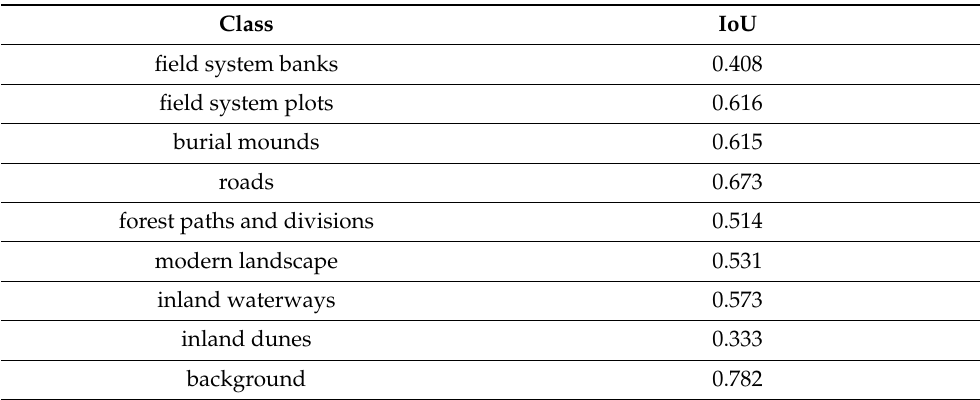
Table 3. IoU metric results for the test set.